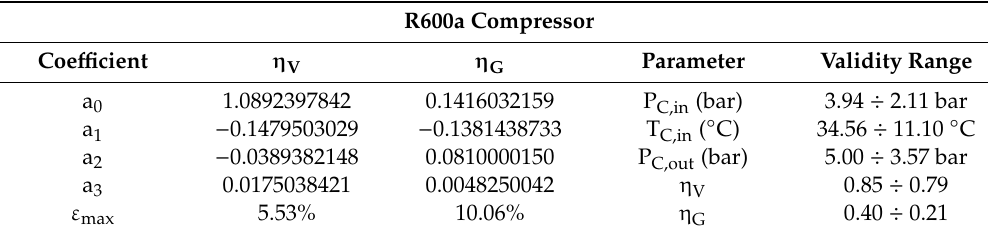
Table 6. Experimental coe ffi cients for the R600a hermetic compressor.